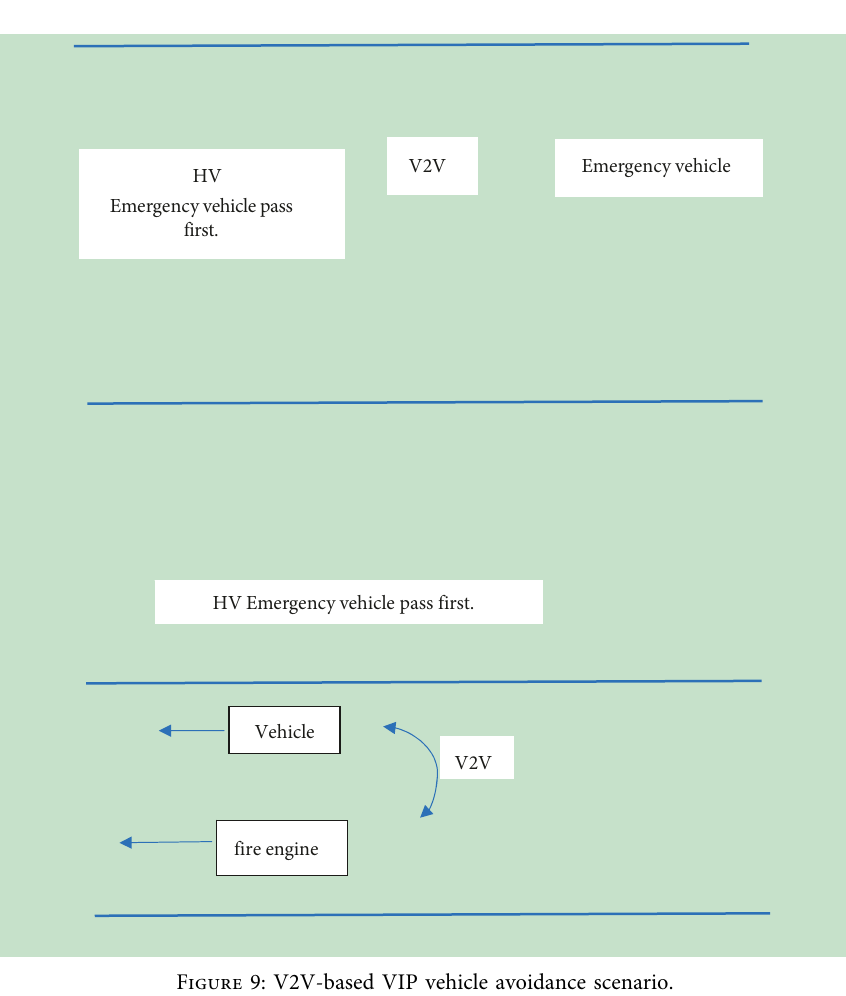
Figure 9: V2V-based VIP vehicle avoidance scenario.